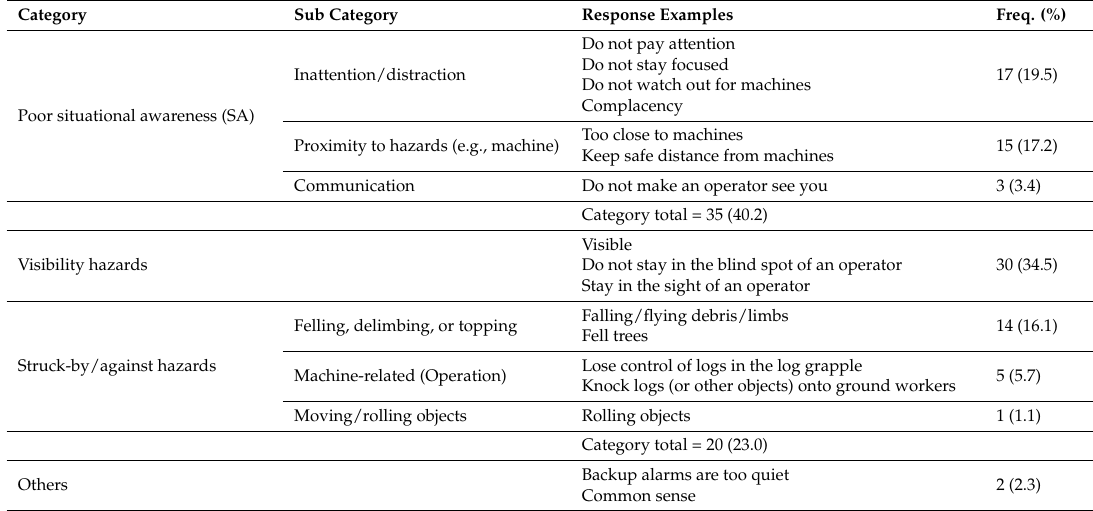
Table 4. Summary of responses ( total = 87, responses from 86 individuals who responded to this open-end question) regarding the biggest safety risks that machine operators perceive for workers on the ground. Note one participant provided two responses, and that n in the table is the number of responses